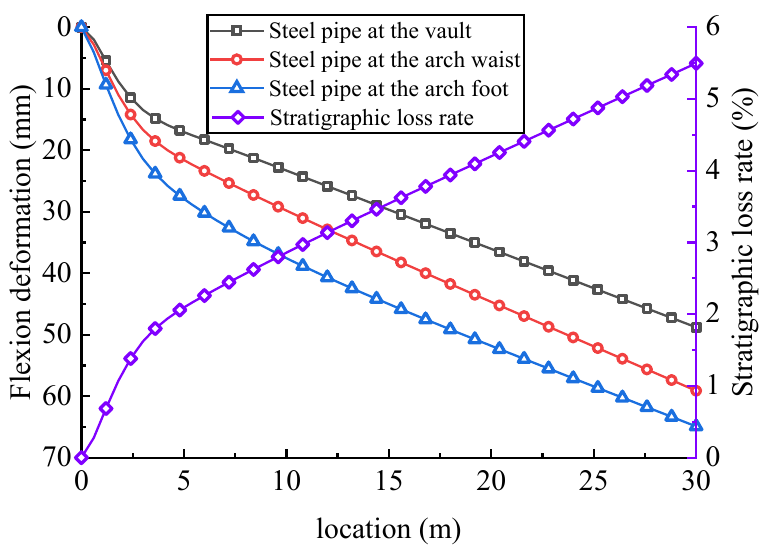
Figure 4. Surrounding rock pressure distribution of steel pipes on different sections.